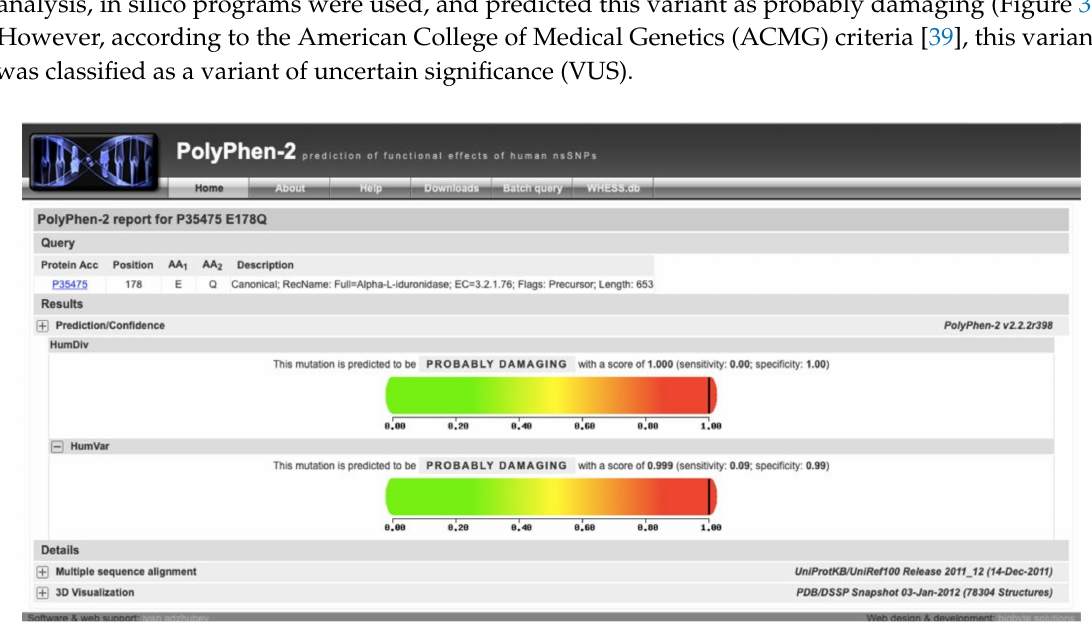
Figure 3. PolyPhen score of 1.000 for the variant p.Glu178Gln. This score predicts the variant to be probably damaging after in silico analysis